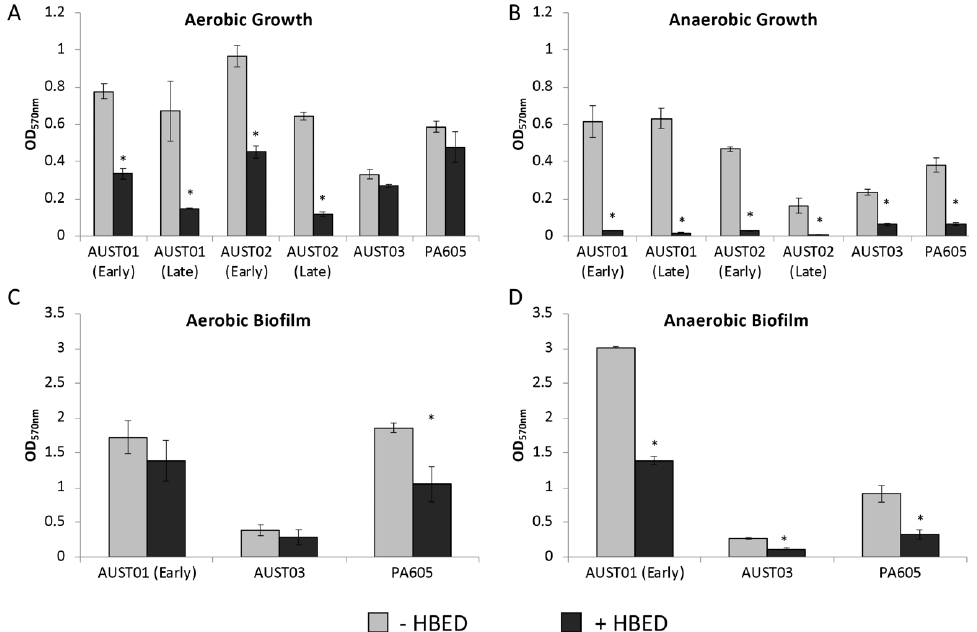
Figure 4. Effect of N,N’ -bis (2-hydroxybenzyl) ethylenediamine- N,N’ -diacetic acid (HBED) on growth and biofilm formation of cystic fibrosis (CF) isolates. Values shown represent the mean level of (A, B) growth and (C, D) biofilm formation +/- standard error of the mean (SEM) of the P. aeruginosa strains AUST01, AUST02, AUST03, and PA605 in succinate medium with 10 µM FeCl 3 in the presence and absence of 100 µ M HBED. Growth was under aerobic ( A , C ) and anaerobic ( B , D ) conditions. * denotes significantly di ff erent values compared to untreated values determined using Student’s t -test ( P <